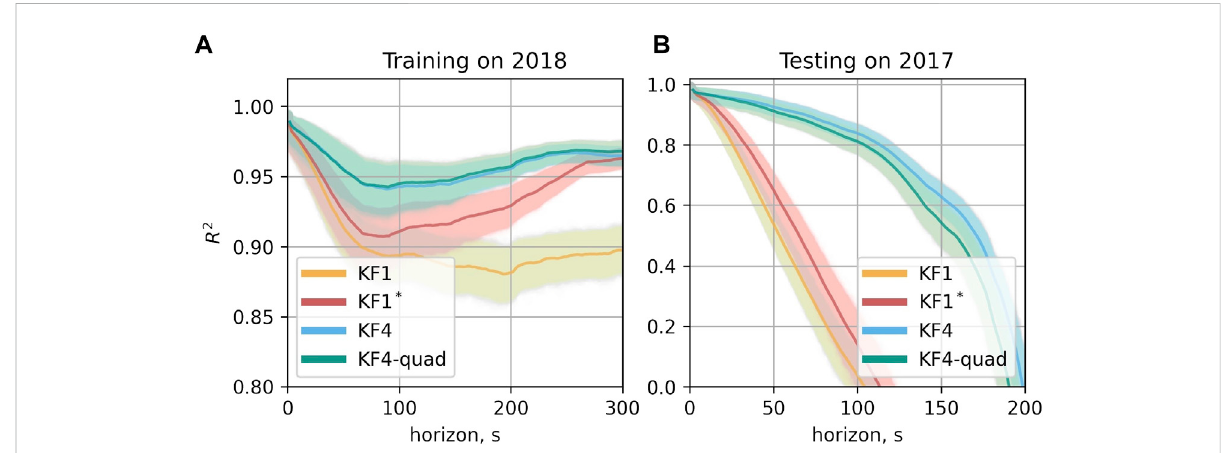
FIGURE 10 R 2 -score as a function of the forecast horizon. (A) On the training dataset, here from 2018 (B) on the test data in 2017.The mean value of R 2 is shown for each horizon in the darker color. The mean value was computed from 1,000 bootstrapped estimates of R 2 , which are shown in the light